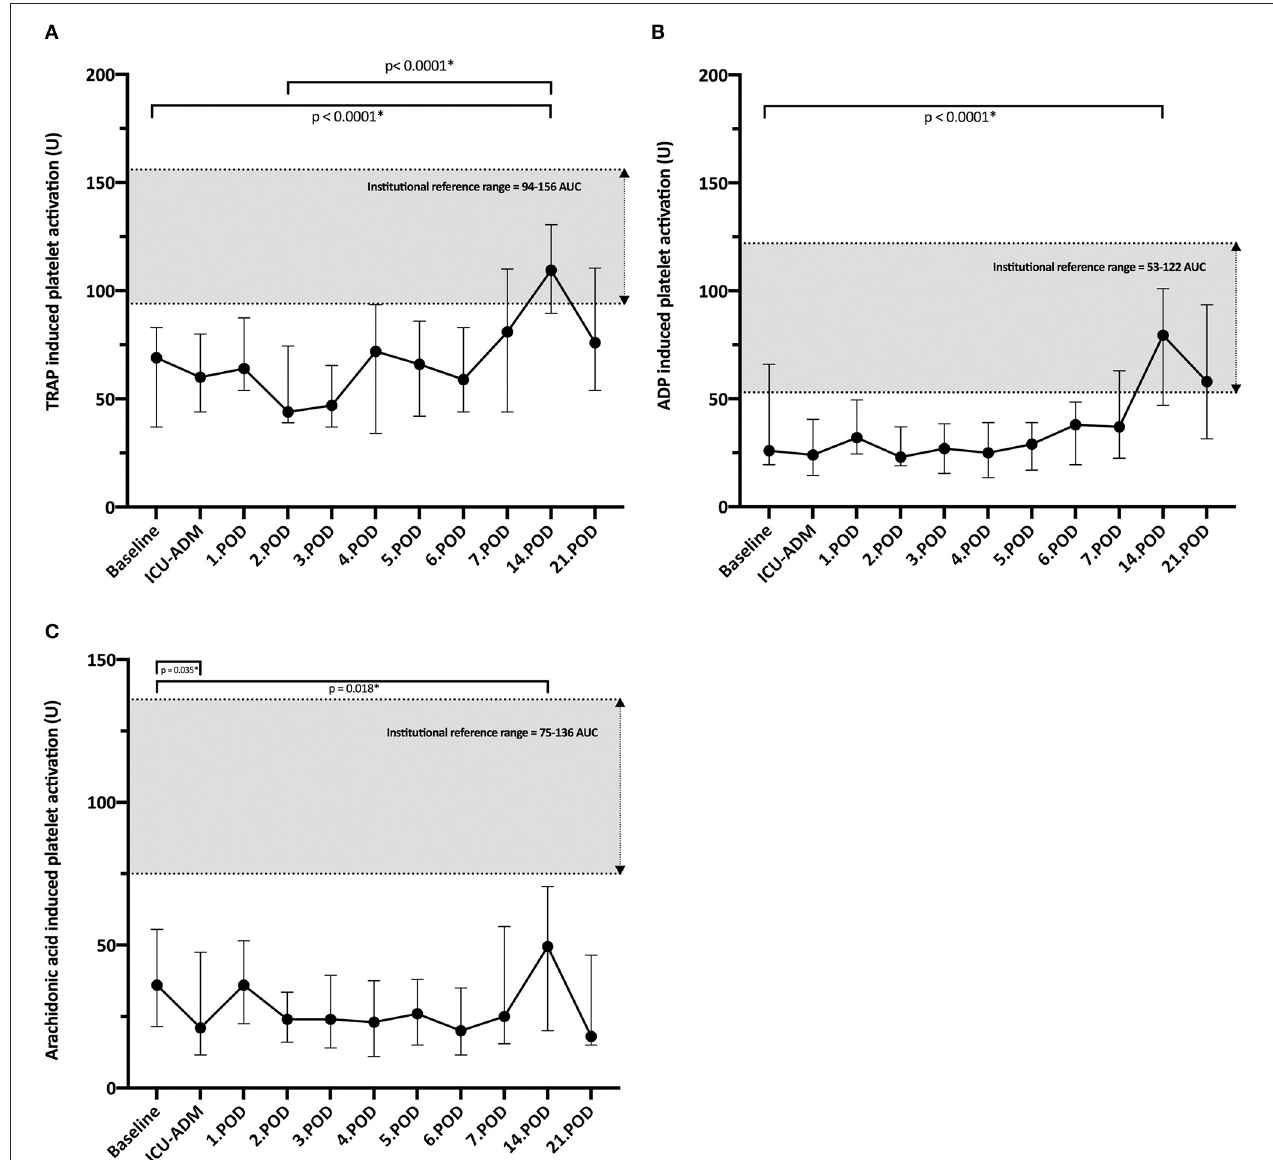
FIGURE 1 | (A) Time course of TRAP-induced platelet aggregation (TRAP, thrombin receptor activator peptide-6) measured by the Multiplate ® Analyzer (Roche Pharma AG, Grenzach-Wyhlen, Germany); U, units; POD, postoperative day; *Non-parametric Wilcoxon test for paired samples. (B) Time course of ADP- induced platelet aggregation; ADP- induced platelet aggregation by the Multiplate ® Analyzer (Roche Pharma AG, Grenzach-Wyhlen, Germany); U, units; POD, postoperative day; *Non-parametric Wilcoxon test for paired samples. (C) Time course of Arachidonic acid -induced platelet aggregation. Arachidonic acid -induced platelet aggregation by the Multiplate ® Analyzer (Roche Pharma AG, Grenzach-Wyhlen, Germany); U, units; POD, postoperative day; *Non-parametric Wilcoxon test for paired